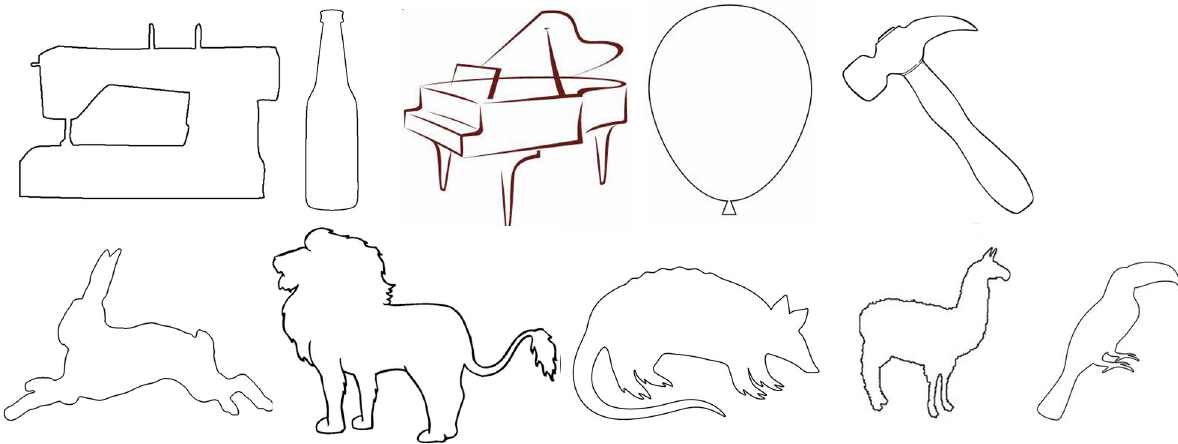
Fig 13. Sample outline stimuli used in Experiment